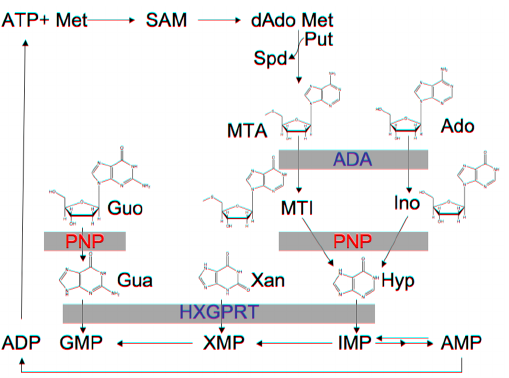
Figure 1. Purine salvage in P. falciparum . The enzymes that comprise the purine salvage pathway in Plasmodium : ADA, adenosine deaminase; PNP, purine nucleoside phosphorylase; HXGPRT, hypoxan- thine-xanthine-guanine phosphoribosyltransferase. Substrates are: MTA, 5 9 methylthioadenosine; Ado, adenosine; MTI, 5 9 methylthioino- sine; Ino, inosine; Hyp, hypoxanthine; IMP, inosine monophosphate; AMP, adenosine monophosphate; XMP, xanthine monophosphate; GMP, guanosine monophosphate; ATP, adenosine triphosphate;